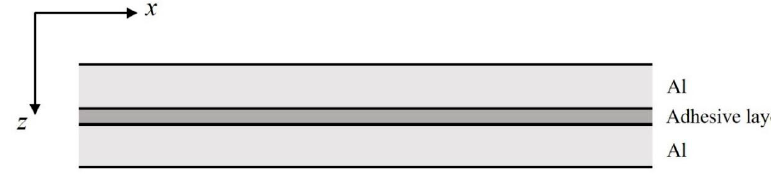
Figure 1. The schematic of the tri-layer adhesive Figure 1. The s chematic of the tri-layer adhesive structure.